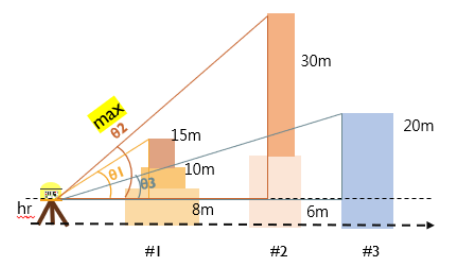
Figure 8. Maximum mask angle calculation (top view)